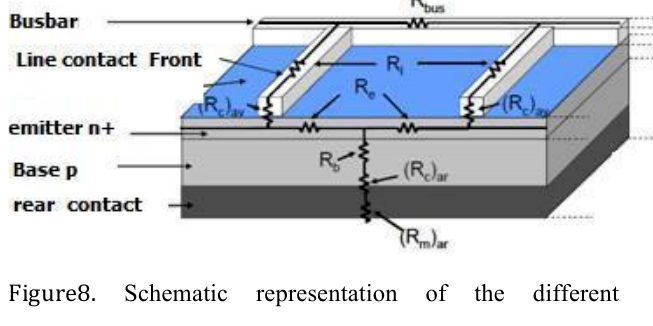
Figure6. Hybrid Autonomous wireless system using the photovoltaic antenna (Solar Cell Antenna)